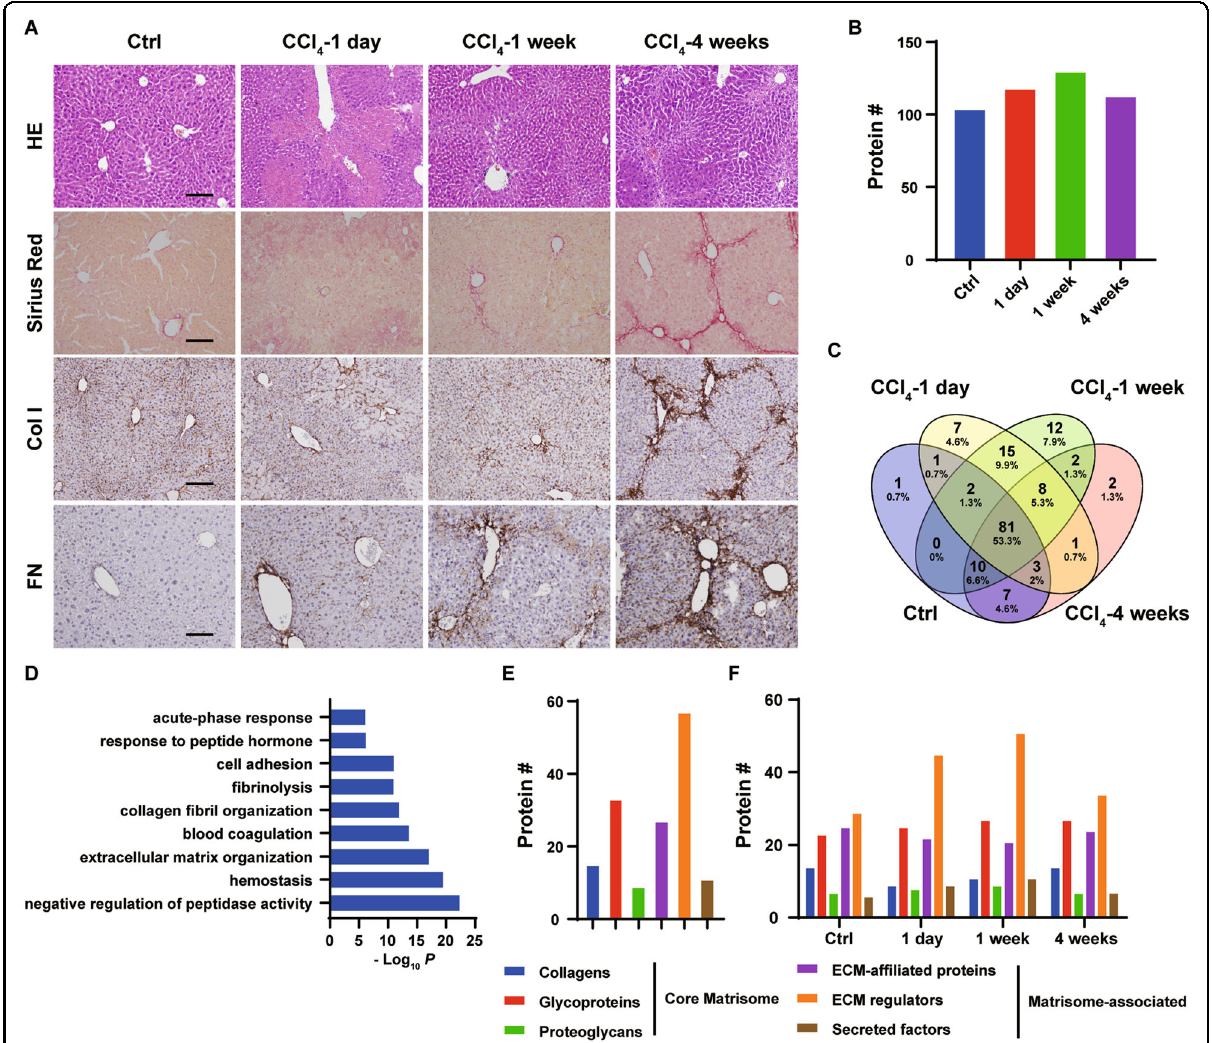
Fig. 1 Identi fi cation of hepatic matrisome composition in CCl 4 -induced liver fi brosis model. A Microscopic views of livers from mice intraperitoneally injected with CCl 4 for 1 day, 1 week or 4 weeks or olive oil for 4 weeks. Liver sections were stained with hematoxylin-eosin (HE), Picrosirius Red or immunostained for type I collagen (Col I) or fi bronectin (FN). Scale bars: 100 μ m. B – E Decellularized and enriched hepatic matrices were subjected to mass-spec analyses. B Numbers of matrisomal proteins identi fi ed at each liver fi brogenesis stage. C Venn diagram depicting overlap of matrisomal proteins across four liver fi brogenesis stages. D Gene ontology (GO) of identi fi ed matrisomal proteins. E Numbers of identi fi ed proteins in matrisomal classes. F Numbers of identi fi ed proteins in matrisomal classes at each liver fi brogenesis